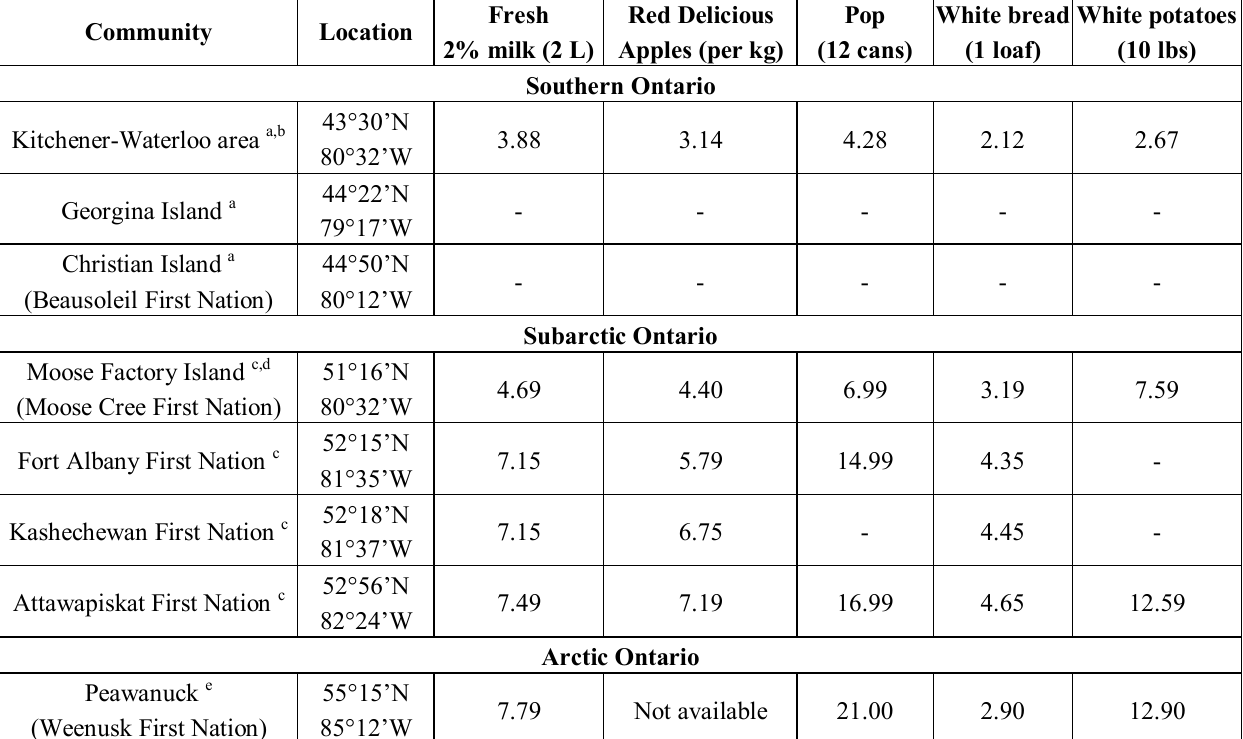
Table 1. A comparison of grocery prices (non-sale items in Canadian dollars) in southern and northern Ontario, Canada, collected in January 2007, except for Peawanuck data which were collected in July